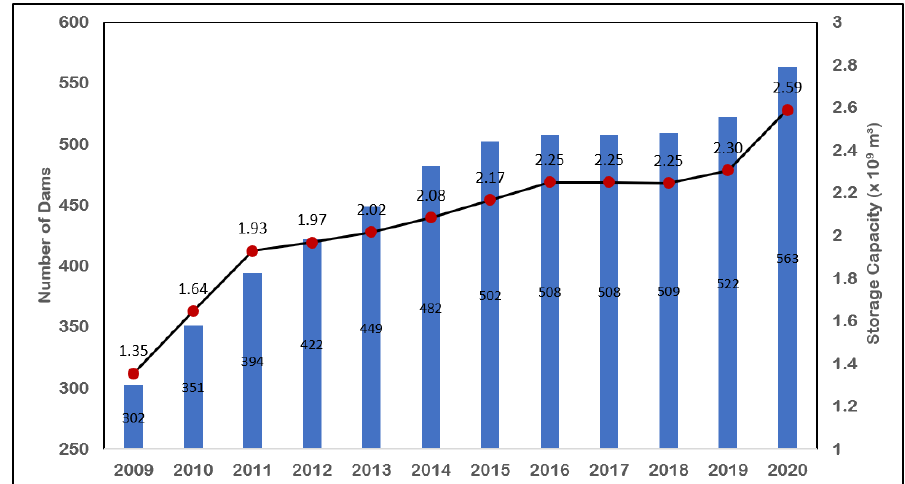
Figure 9. Existing dams in Saudi Arabia and their total capacity.